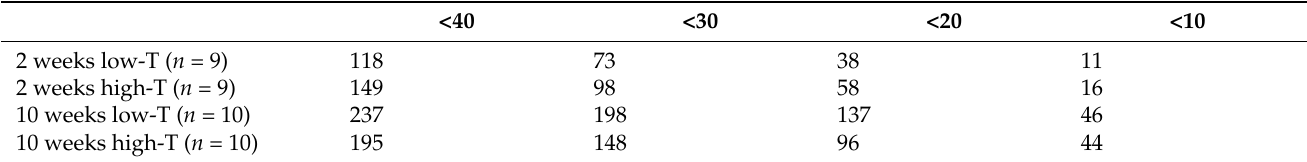
Table 2. Number of sites of thinned mucosa categorized according to the width.